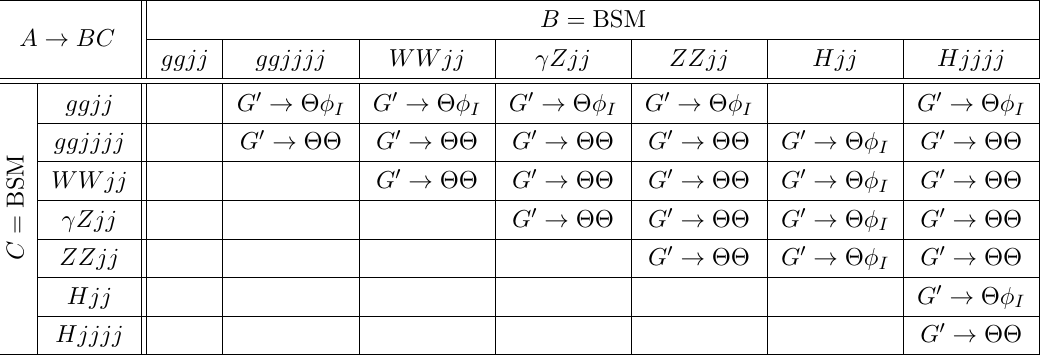
Table 11 . Example (Group X in table 1) for A ! BC , where A , B and C are BSM particles, where both B and C decay to more complex (cid:12)nal states. The j includes a t , b , and light-(cid:13)avor quarks. The G 0 , (cid:2), and (cid:30) I denote a coloron, color-octet scalar, and a singlet scalar respectively [33, 34].